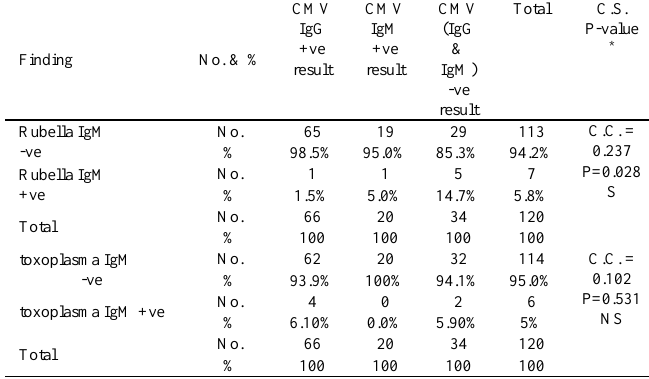
Table 2 : Prevalence of Rubella -IgM and